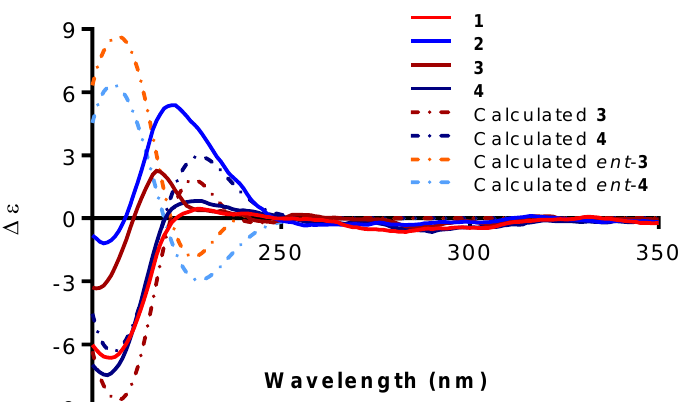
Figure 3. Experimental ECD spectra for compounds 1 – 4 . Calculated ECD spectra for 3 (burgundy dashed line), ent - 3 (orange dashed line), compound 4 (navy dashed line) and ent - 4 (sky-blue dashed line). A negative shift of − 20 nm was required to match the spectra.